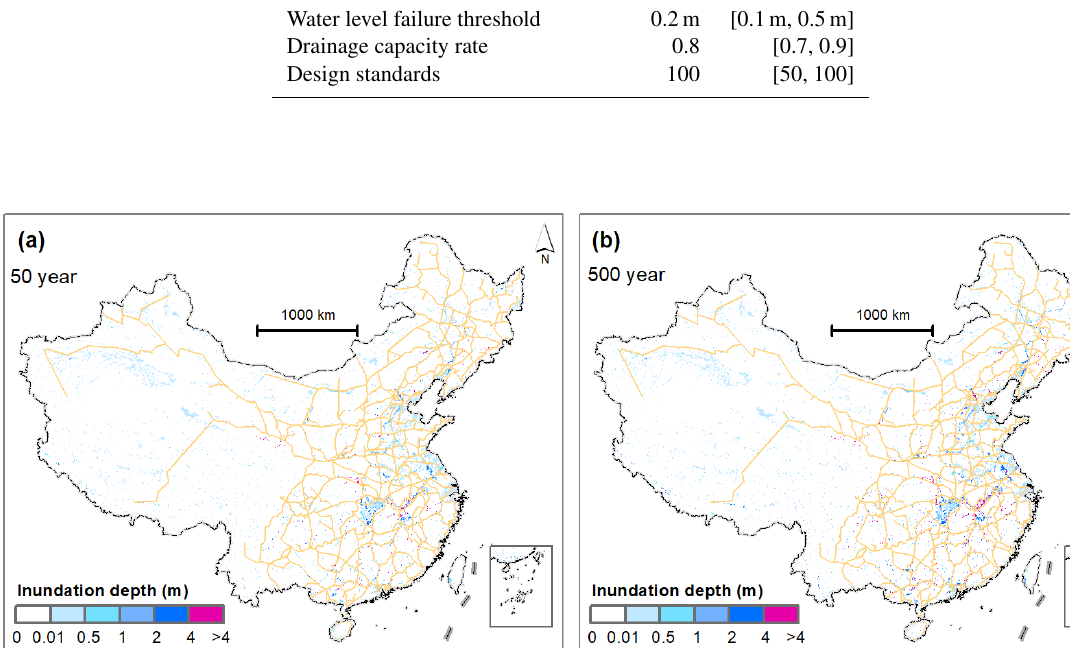
Figure A1. (a) The 50-year flood and (b) the 500-year flood.